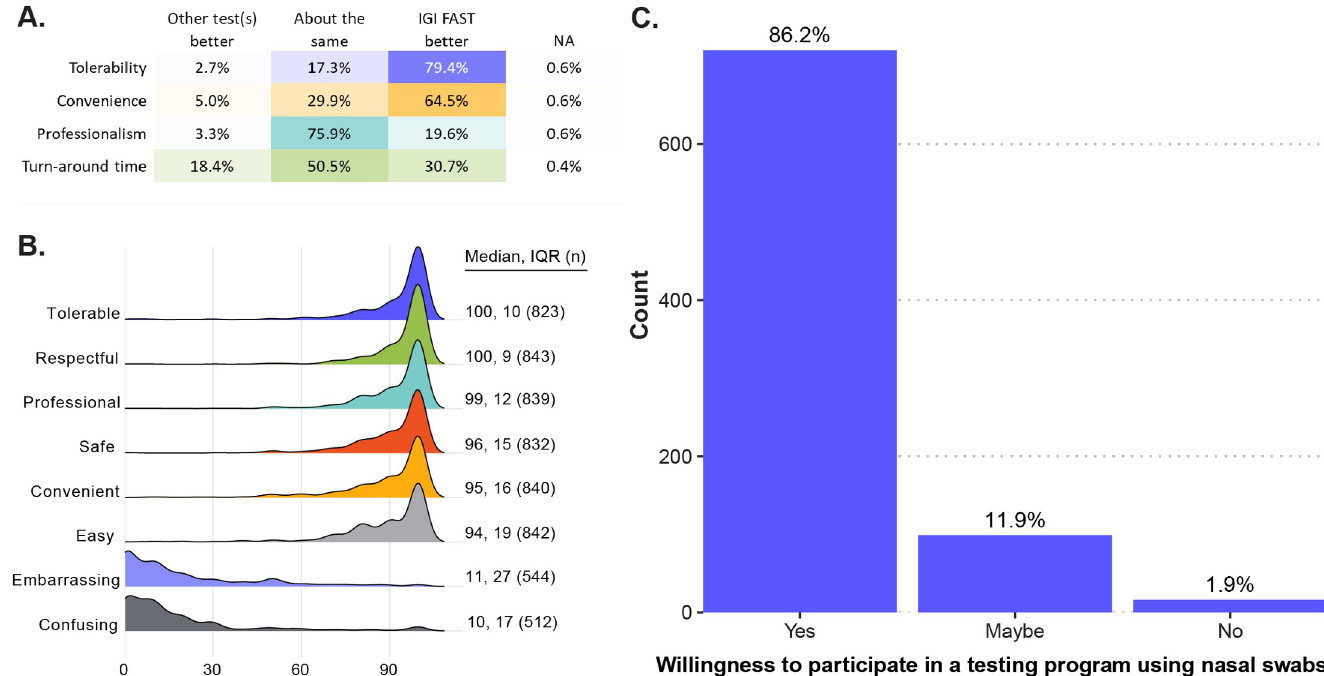
Fig 5. Participant reviews of IGI FAST. IGI FAST was well-reviewed by participants. (A) To exit survey respondents who reported having done a respiratory swab- based SARS-CoV-2 test outside of IGI FAST (n = 515), IGI FAST was superior regarding tolerability and convenience. (B) When exit survey participants were asked how well various words described their experiences with the IGI FAST test, testing sites, or personnel, IGI FAST received favorable responses. (C) When asked whether participants would continue participating in a testing program using a nasal swab instead of IGI FAST, most respondents indicated a willingness to continue participation (n = 839). Of note, this question specified the hypothetical continued program would use nasal swabs instead of nasopharyngeal swabs, clarifying the difference between the two.